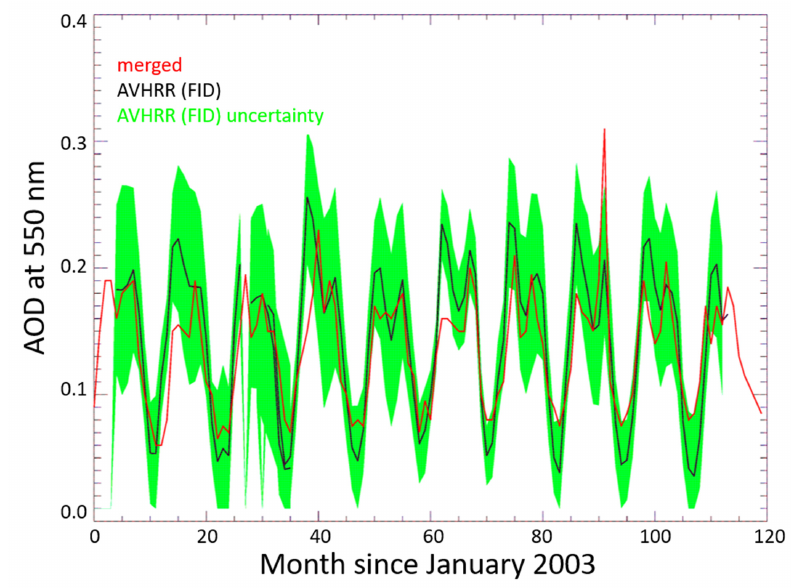
Figure 10. Monthly AOD records over Europe (land only): FIDUCEO AVHRR and multi-sensor merged dataset [16].